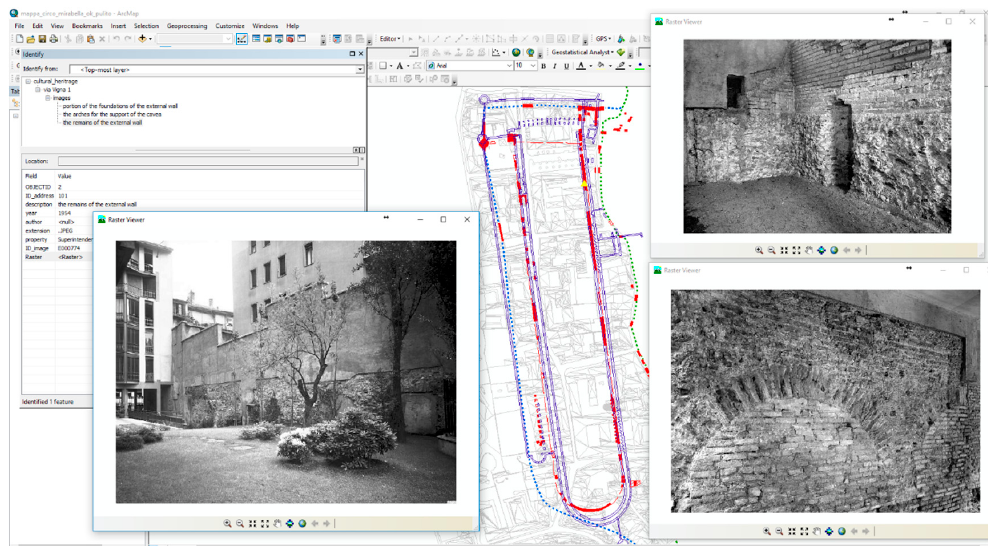
Figure 10. The creation and implementation of the geodatabase connected to all the different portions of the circus’ walls identified and surveyed with the metadata related to the ruins and to the archival images collected.